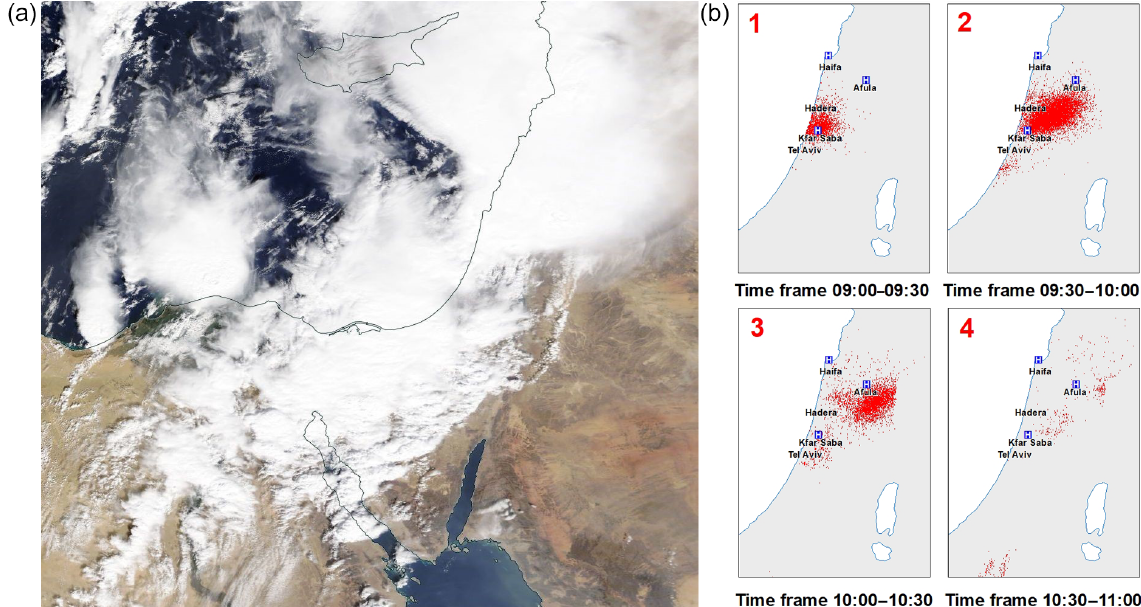
Figure 3. (a) Visible MODIS satellite image at 12:00UT when the cold front and thunderstorms had moved into Israel. (b) Lightning strikes detected on 25 October 2015 by the ILDN (Israel Lightning Detection Network) operated by the IEC. Each point is a ground strike. The panels show cumulative values at 30min intervals, local time and the location of the three hospitals involved in the research.